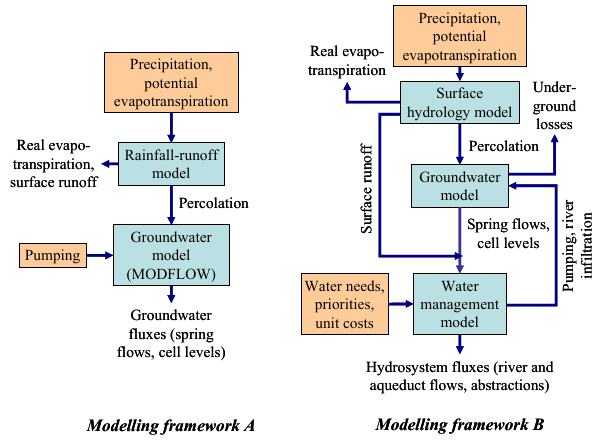
Fig. 1. Synoptic sketch of the two modelling Figure 1